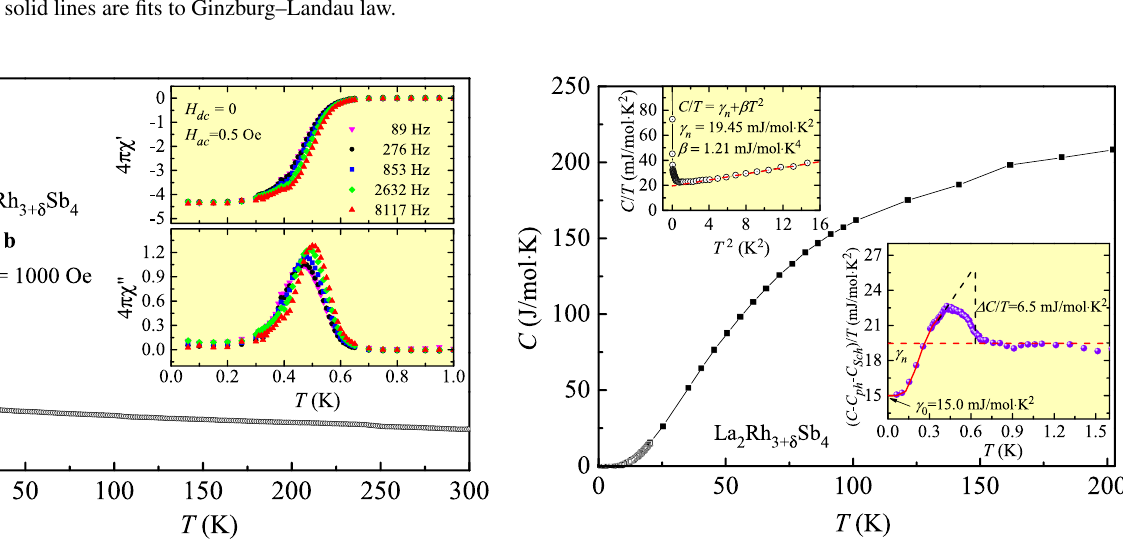
Figure 4. Electrical resistivity of La 2 Rh 3 + δ Sb 4 . (a) ρ b ( T ) profile showing superconducting transition with T on c = 0 . 8 K and T 0 c = 0 . 65 K. Figures (b) and (c) for ρ b ( T ) measured under magnetic field H ⊥ b and H ∥ b , respectively. (d) Temperature dependent upper critical field µ ( T ) ; the solid lines are fits to Ginzburg–Landau law. 0 H c 2